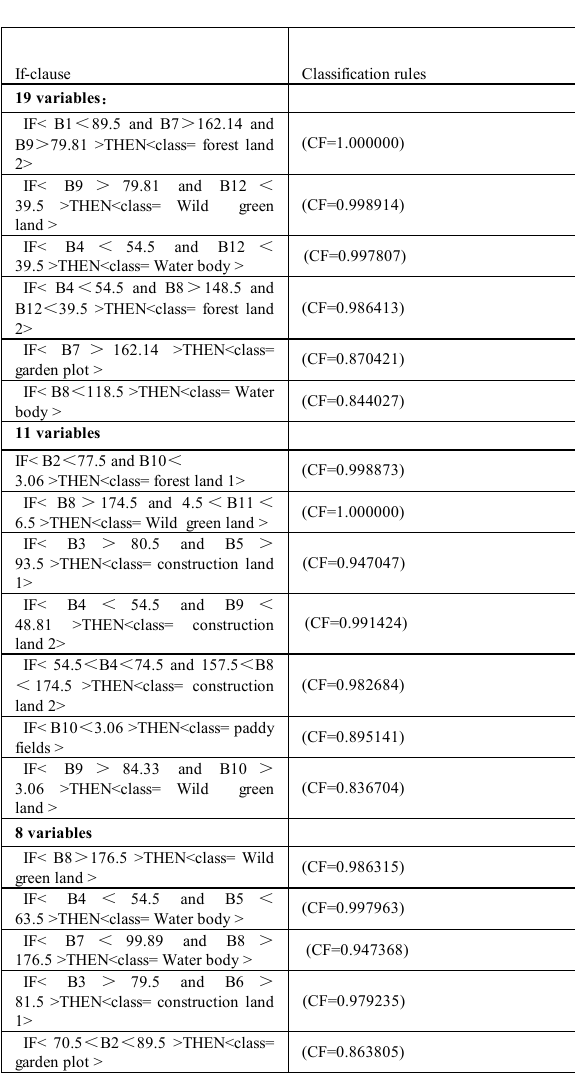
Table4. Parts from rules of landuse/cover classification in the test area